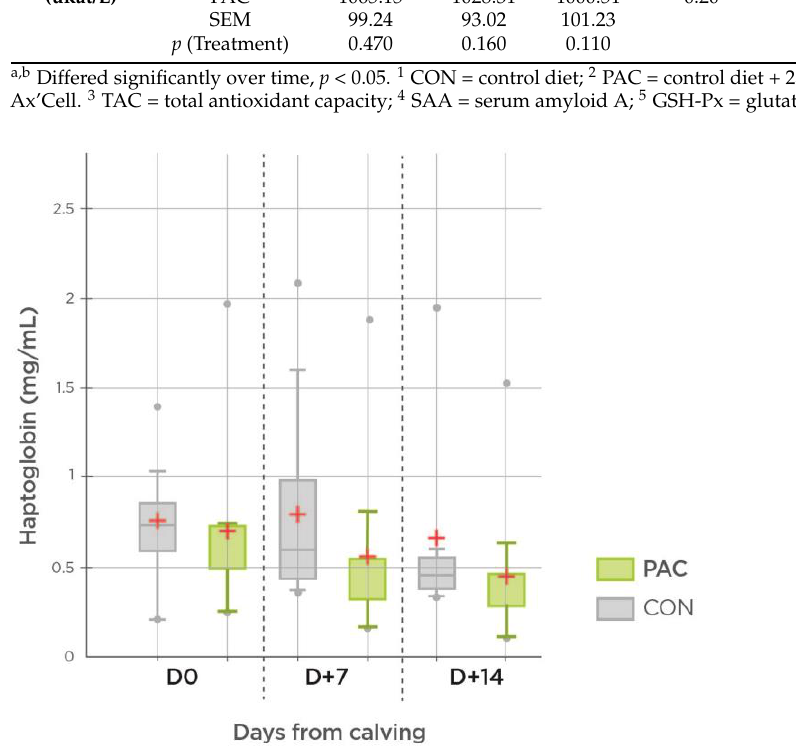
Table 5. Hematological parameters in cows receiving plant bioactive compounds.